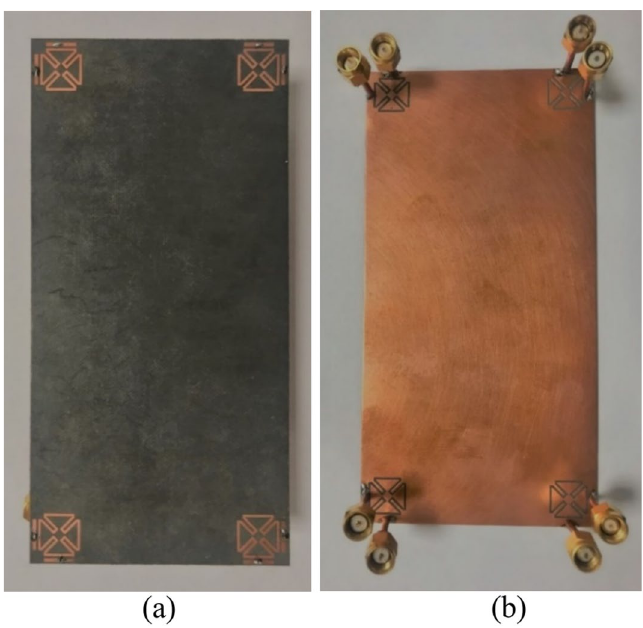
Figure 11. ( a ) Front, ( b ) back schematics of the fabricated MIMO smartphone